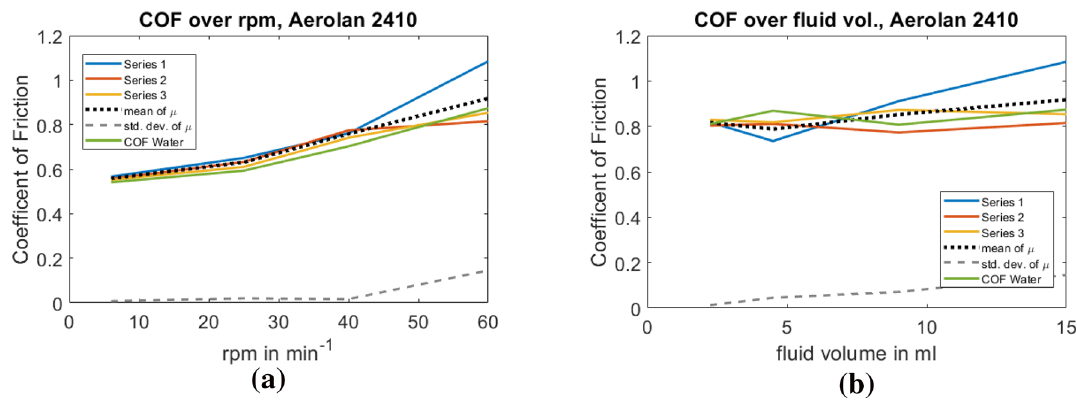
Fig. 4 Measured friction coefficient for an Aerolan 2410 (10% emulsion): a over rotational speed at full filling, b over fluid volume at 40 rpm